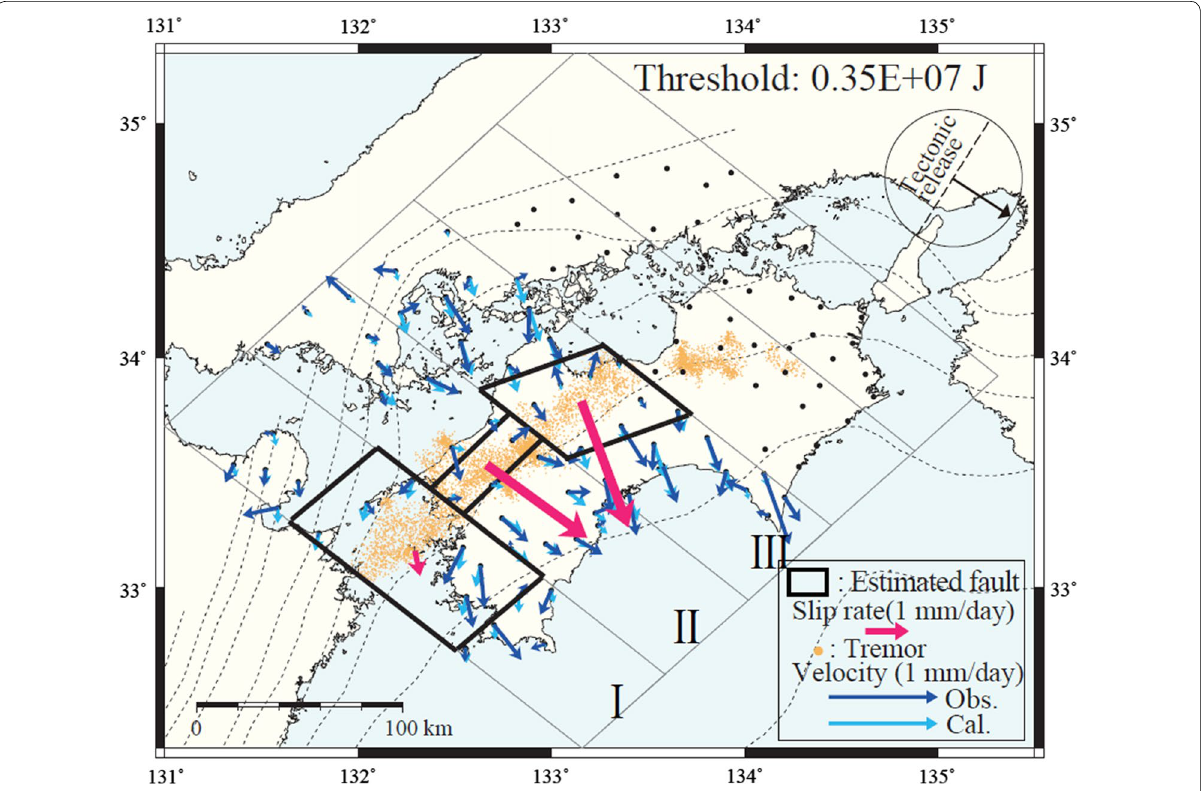
Fig. 6 Examples of estimated rectangular fault models in our study with a tremor energy threshold of 0.35 × 10 7 J . Black tetragons indicate parts of the estimated fault cut by segment boundaries. Pink allows indicate the estimated slip velocities. Orange dots indicate the epicenters of non-volcanic tremor estimated by Annoura et al. (2016) during our analysis period in each segment. Blue arrows are the same as in Fig. 5. Light blue arrows indicate the calculated surface velocities obtained using the estimated rectangular fault models